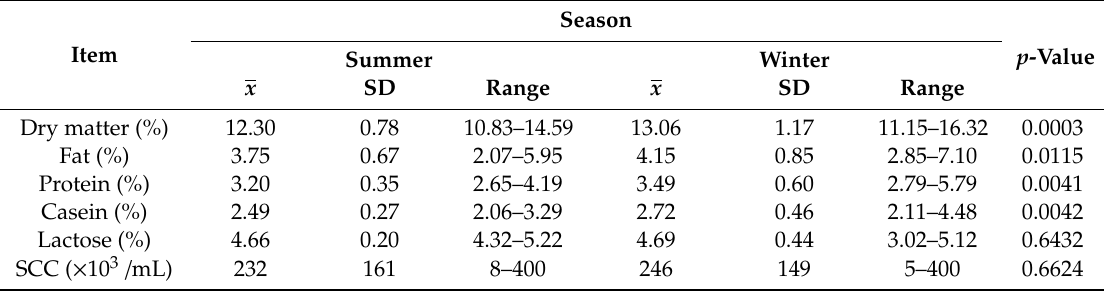
Table 1. Chemical composition of milk and somatic cells count depending on the season.